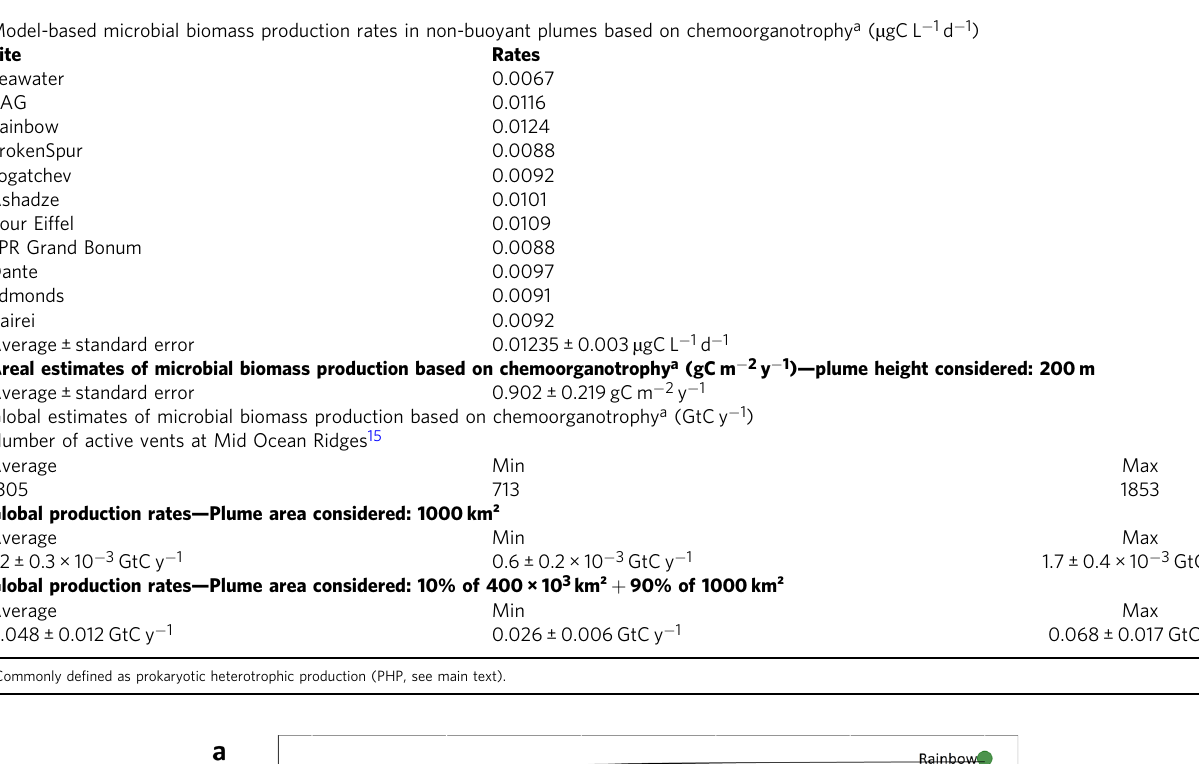
Table 2 Compilation and global estimates of microbial biomass production rates through chemoorganotrophy a within hydrothermal non-buoyant plumes (NBP).